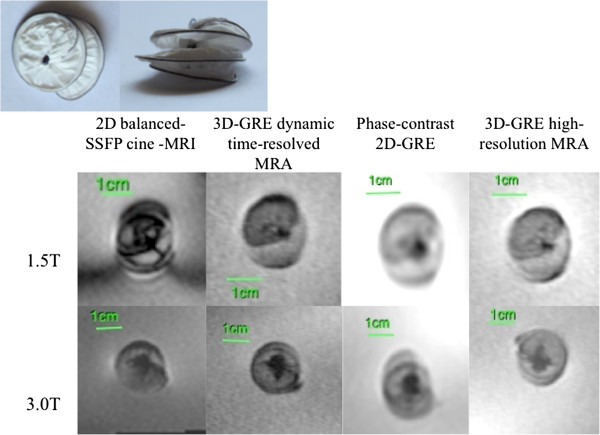
MR appearance of Helex Occluder (Device 8).